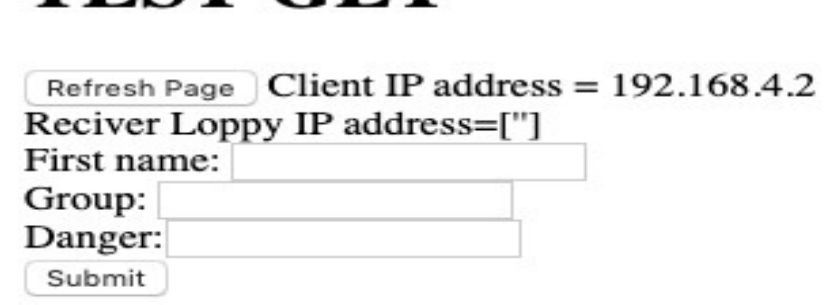
Figure 7. Transmission of information from LoPy transmitter to LoPy bridge (Receiver). Table 3. First experimentation study, information required from devices near the LoPy transmitter sent via the LoPy bridge to the LoPy receiver with 192.168.4.1/test. This communication model can be applied between transmitter–bridge as well as between bridge–receiver.